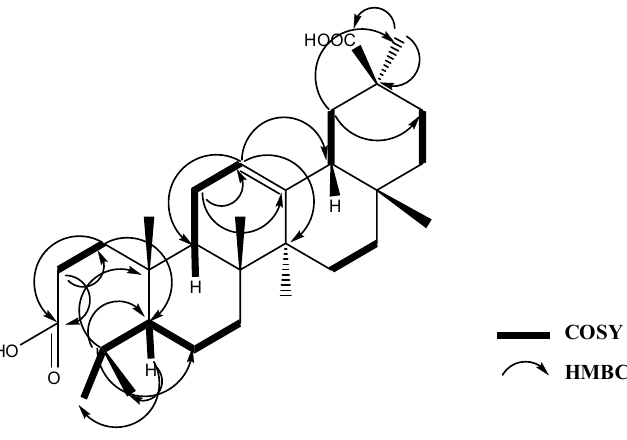
Figure 3. Key HMBC and COSY correlations of compound 4 .